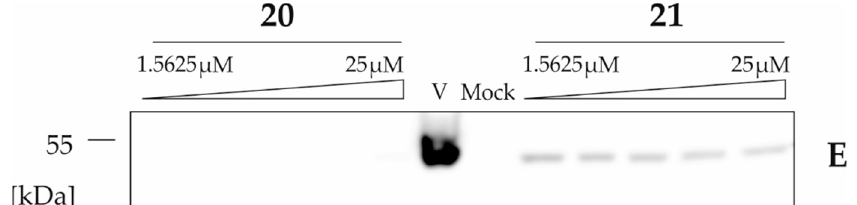
Figure 6. Analysis of TBEV E glycoprotein synthesis after treatment with uridine glycoconjugates. A549 cells were infected with TBEV Neudoerfl strain, MOI of 0,1. At 2 h p.i., cells were treated with various doses of compound 20 , 21 or DMSO diluted in the medium for 48 h. Cell lysates were prepared and separated by SDS-PAGE (gradient 10–20% polyacrylamide). The E protein was detected in Western blot analysis using monoclonal anti-Flavivirus group antigen antibody (4G2).